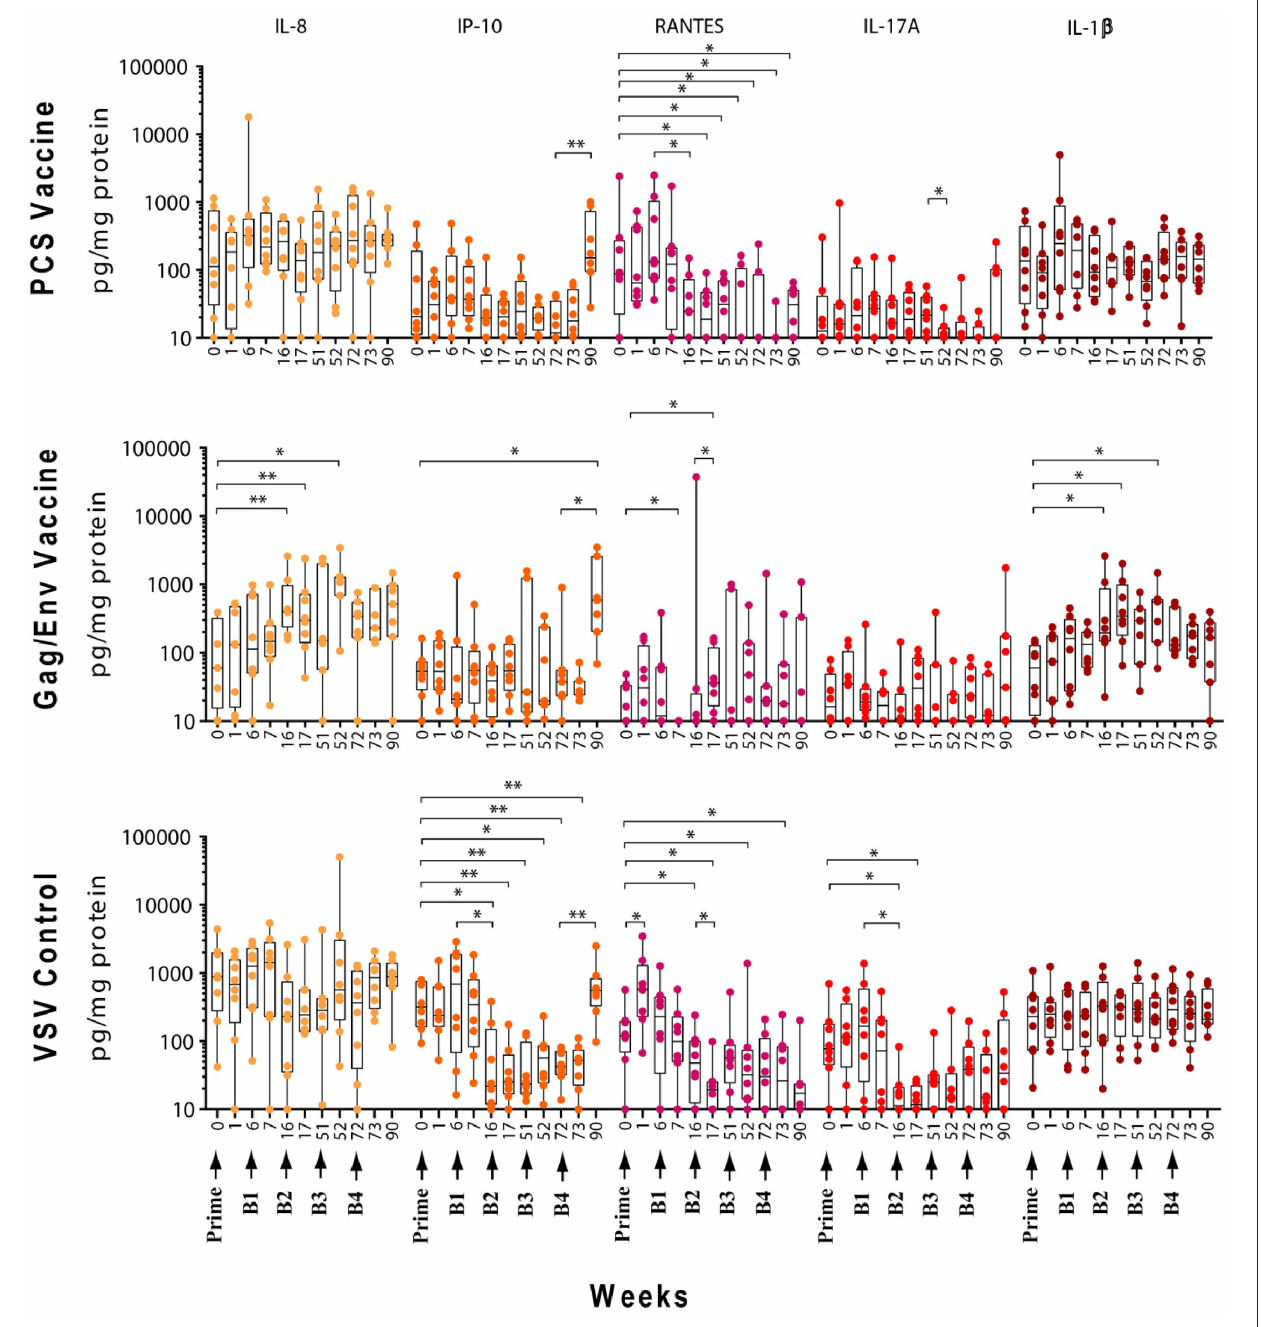
FIGURE 3 | Significant changes in the CVL levels of IL-8, IP-10, RANTES, IL-17A, and IL-1 β after immunization and multiple boosts analyzed using Wilcoxon matched- pairs signed-rank paired t -test. Data presented as values from individual monkeys with median and range. Arrows indicate immunization. n = 8 monkeys/group ( n = 7 for Gag/Env). Experiments were run in duplicates. * P < 0.05 and ** P < 0.01.